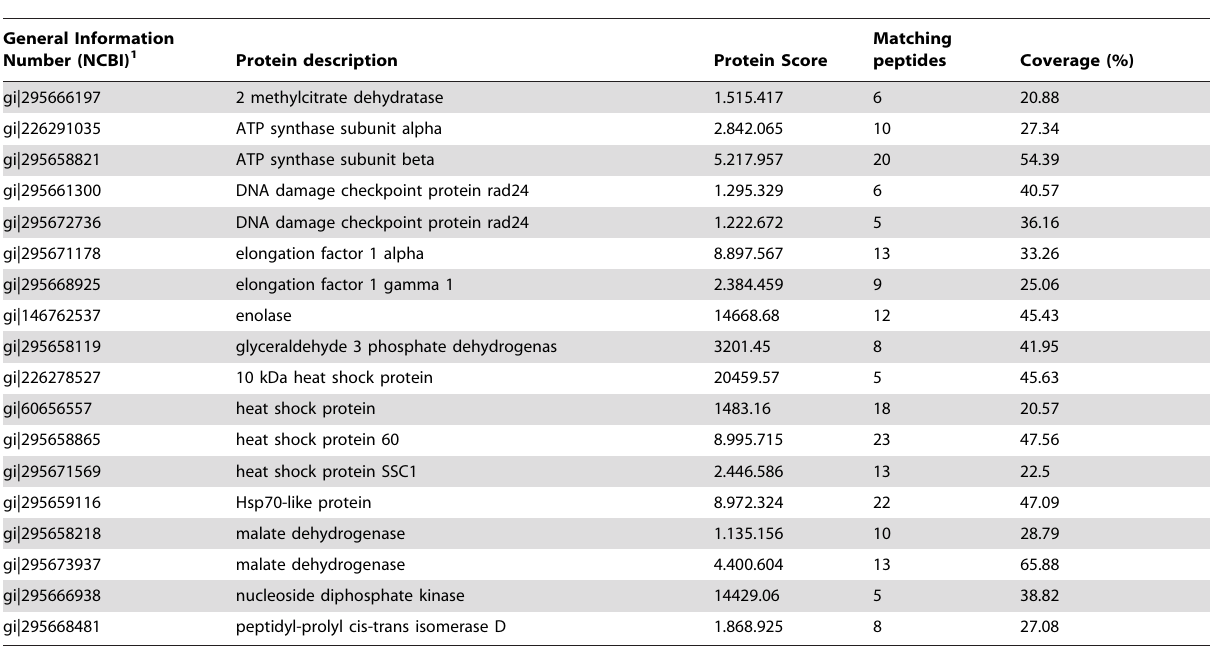
Table 4. Paracoccidiodes, Pb 01 yeast cells secreted proteins in macrophages by nanoLC-MS/MS.